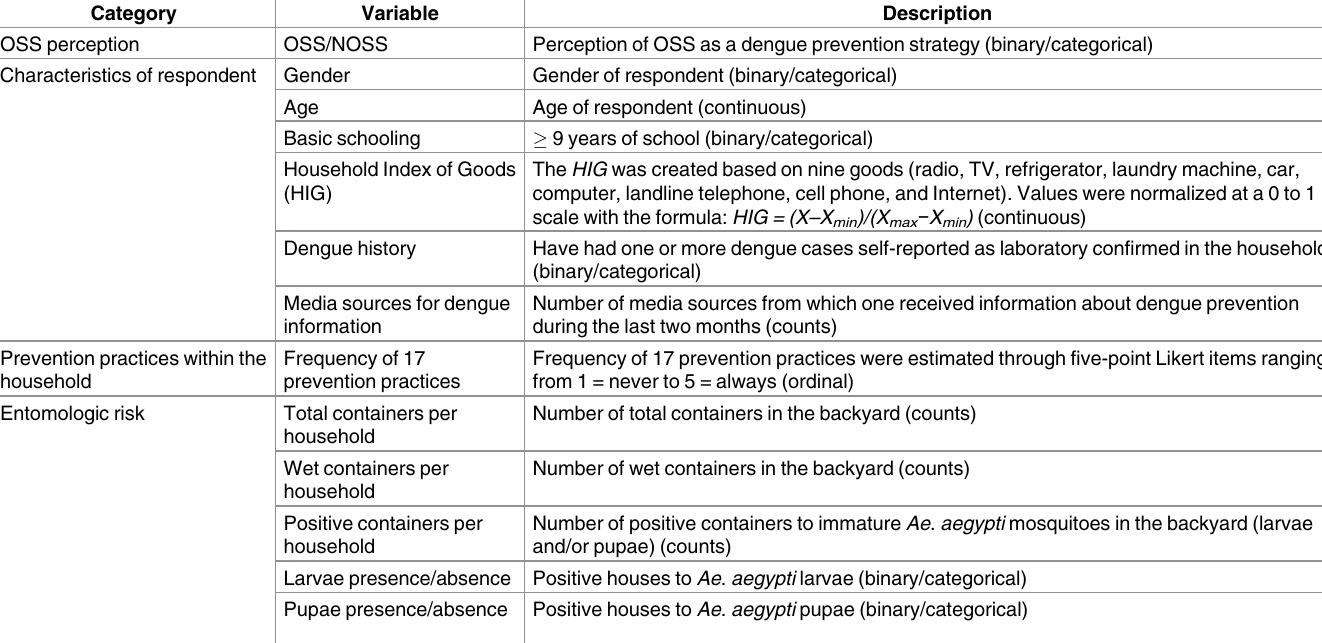
Table 1. Description of study